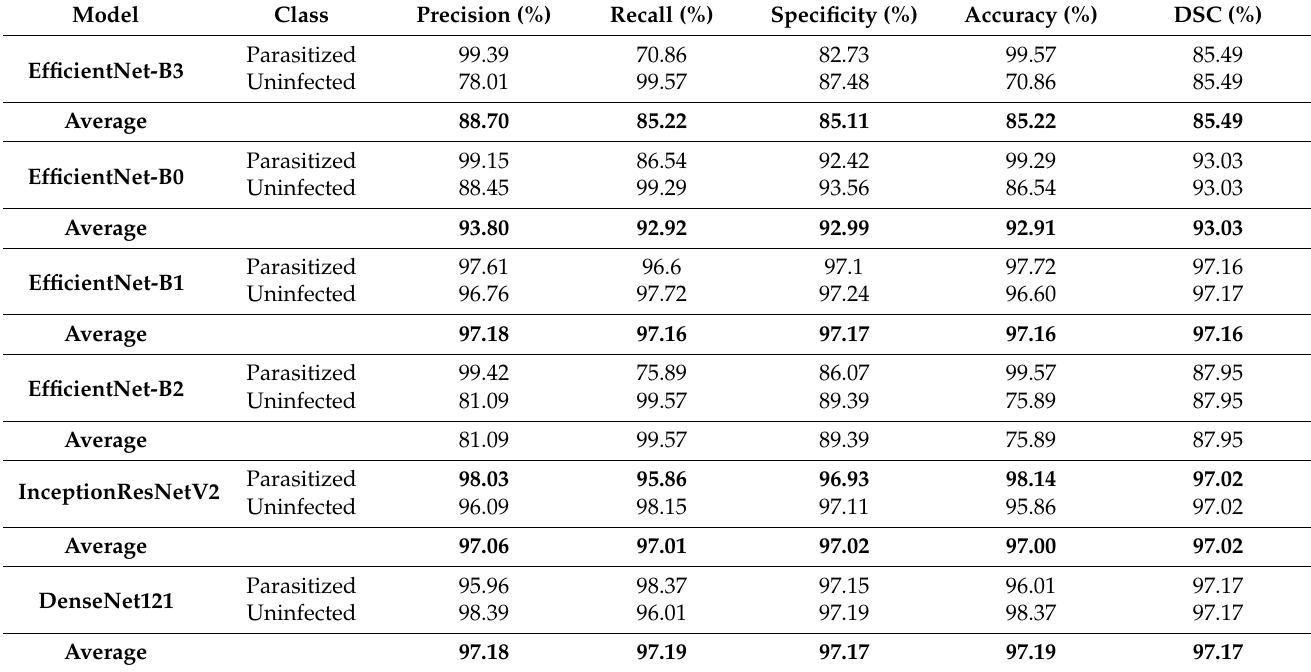
Table 5. The performance of binary classification of malaria parasite for the six CNN models using a fixed